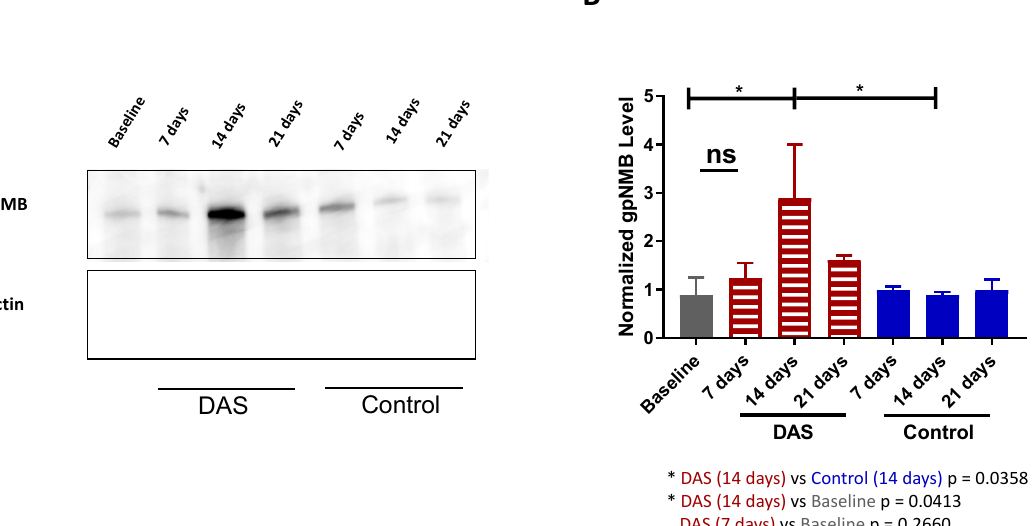
Figure 4. Dasatinib can upregulate the expression of gpNMB in MDA-MB-468-bearing mice. The mice were separated into two groups and were treated with either dasatinib or vehicle control for 21 days. Subgroups of mice (n = 4) were euthanized at different timepoints. Tumors were then subjected to Western blot analyses of gpNMB and β -actin. ( A ) Western blot images of gpNMB and β -actin; ( B ) Plot of normalized gpNMB expression with β -actin. DAS = dasatinib. ns = not